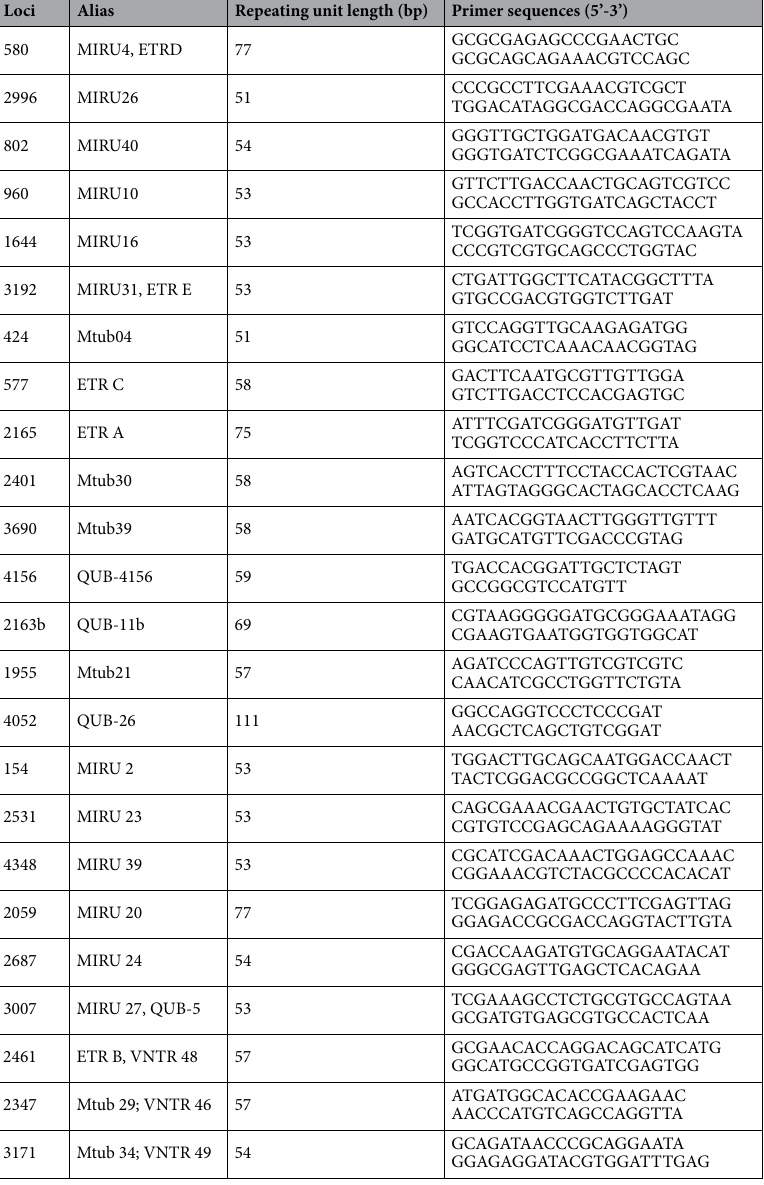
Table 5. PCR primer sequences and MIRU-VNTR locus designations 1 used in this study. 1 Extracted from Yasmin et al. 27 . Primers were synthesized by Inqaba Biotec (South